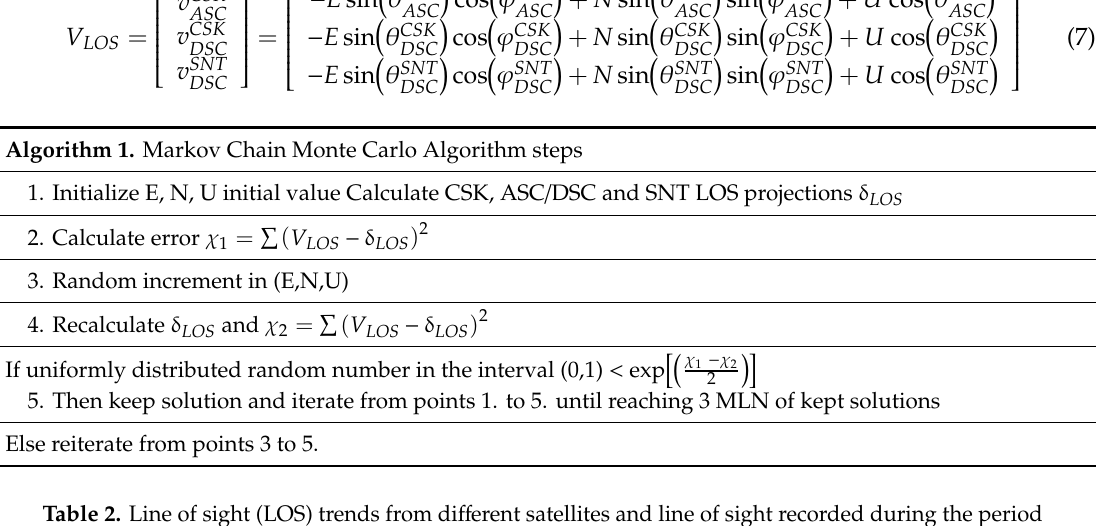
Table 2. Line of sight (LOS) trends from di ff erent satellites and line of sight recorded during the period 2015–2018. Reference point for each pillar are displayed in Figure 4A. West / East are referred to points located at the deck level (located on the west / east side) near the strands while average refers to the average trend of the deck. “ / ” indicates no persistent scatterer (PS) coverage in the area. Systems 9–11 refer to the balanced system numbers as listed in Figures 1 and 4. North, South and Ground indicates where the pixels are located on the northern side, southern side, or at the base of the bridge,